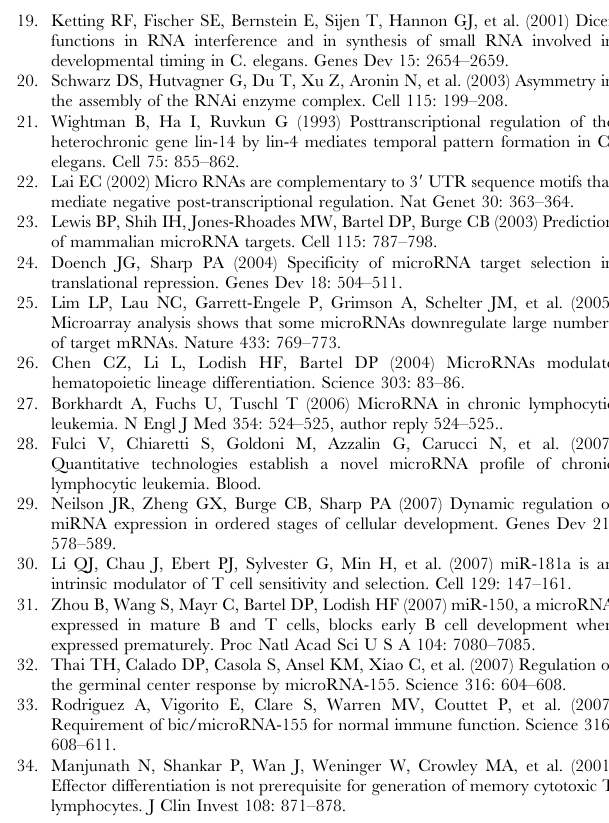
Table S3 Normalized miRNA cloning frequency in T cell subsets. The percent cloning frequency in Supplemental Table 1